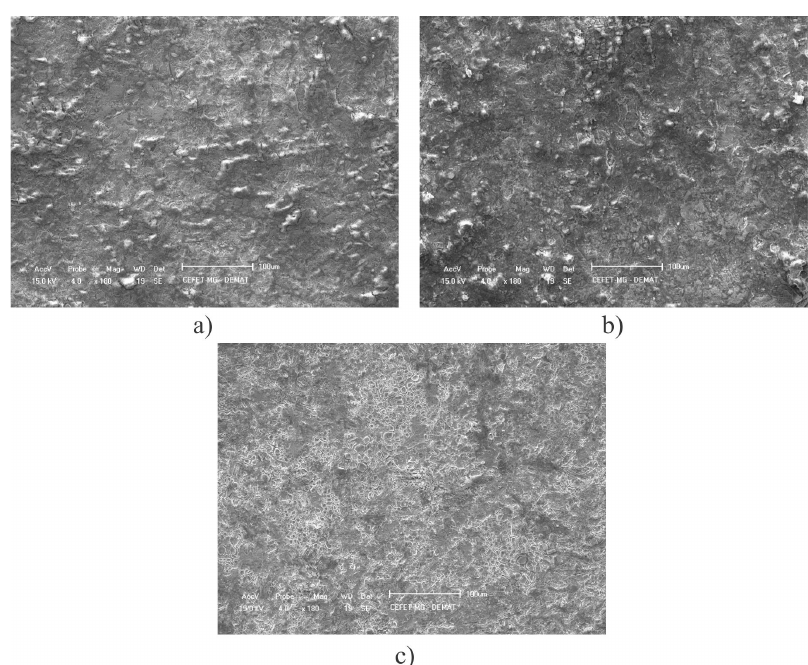
Figure 5. NiO coating of samples “J2” (a), “J3” (b) and “J4” (c).